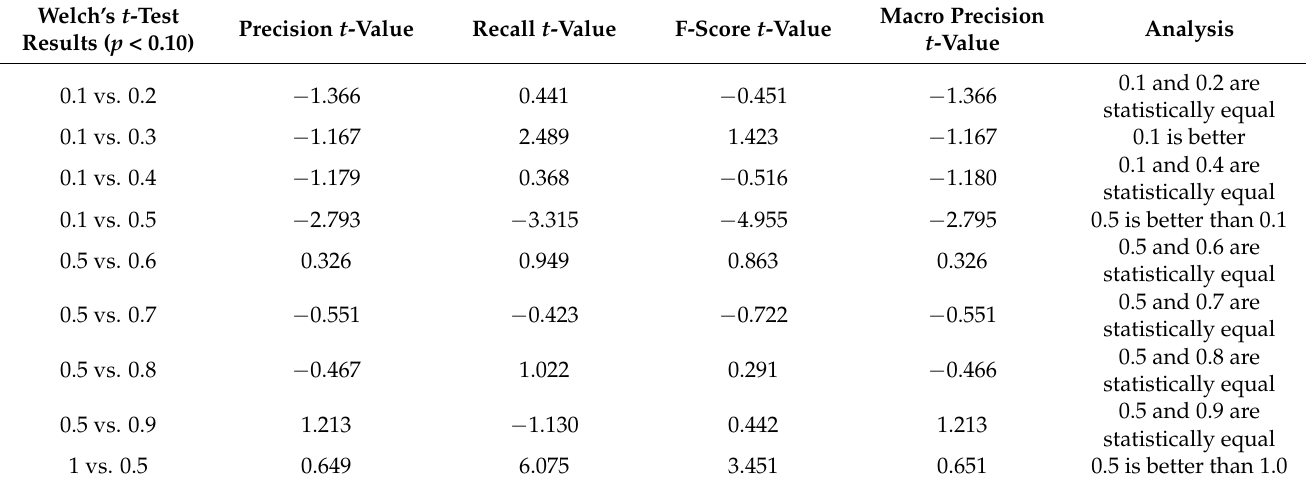
Table 6. Welch’s t -test results: UNSW-NB15: Worms—random undersampling before